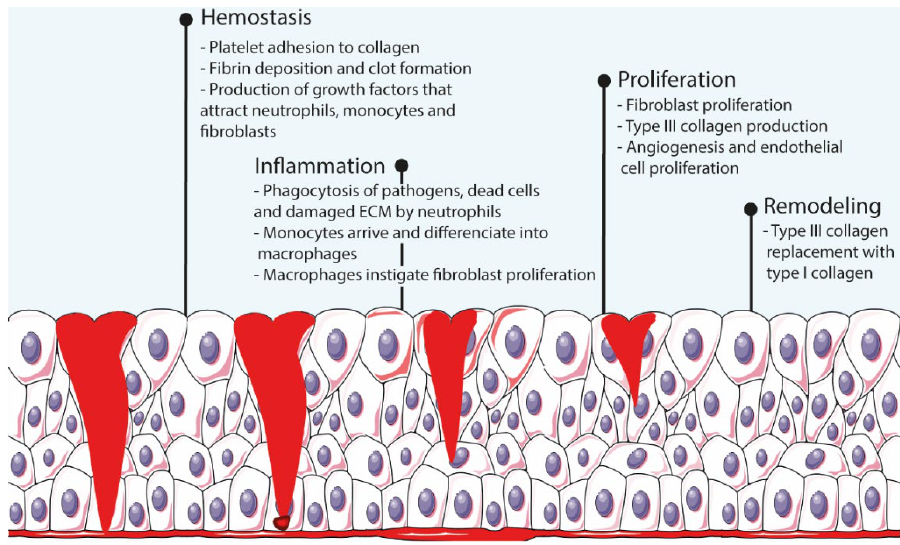
Figure 1. Schematic representation of the wound healing process.